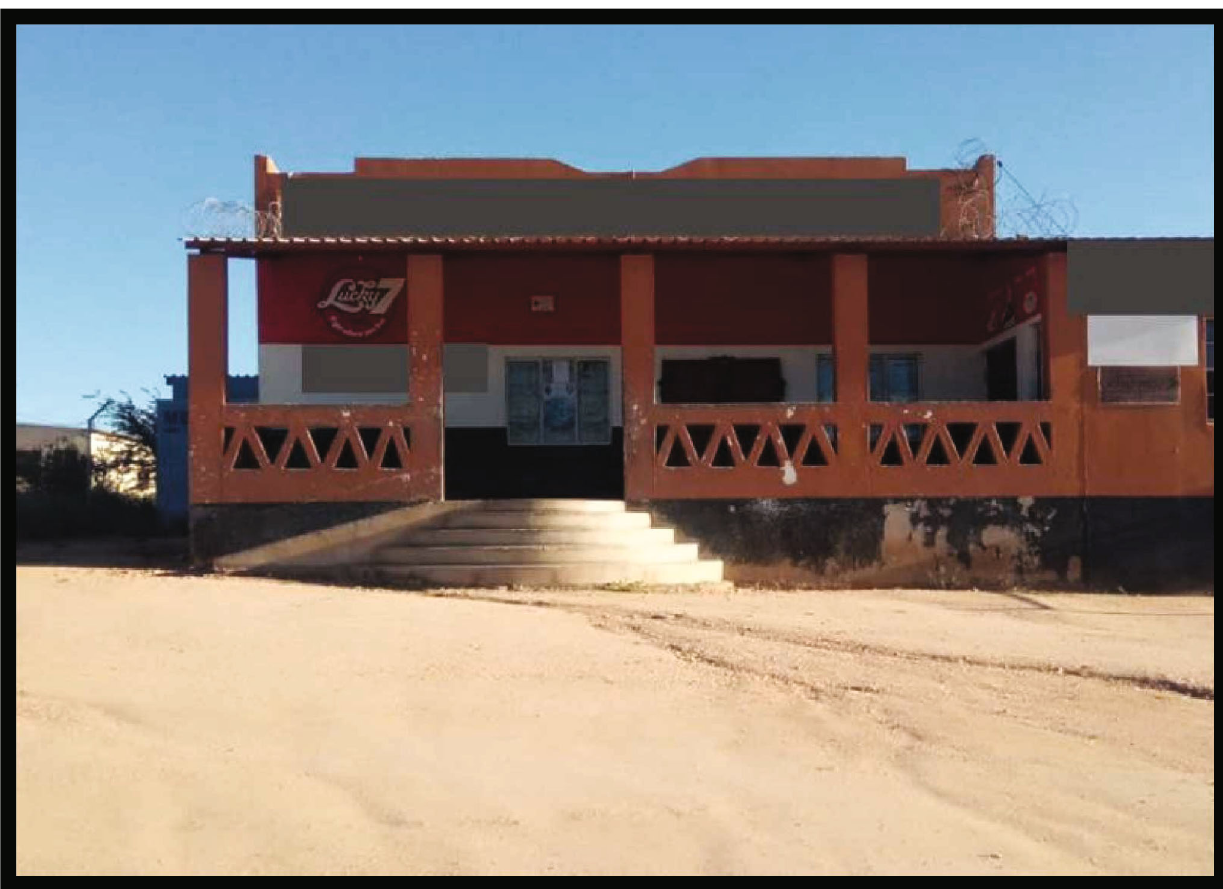
Figure 8: Community butchery with no accessibility to wheelchair users and people with mobile